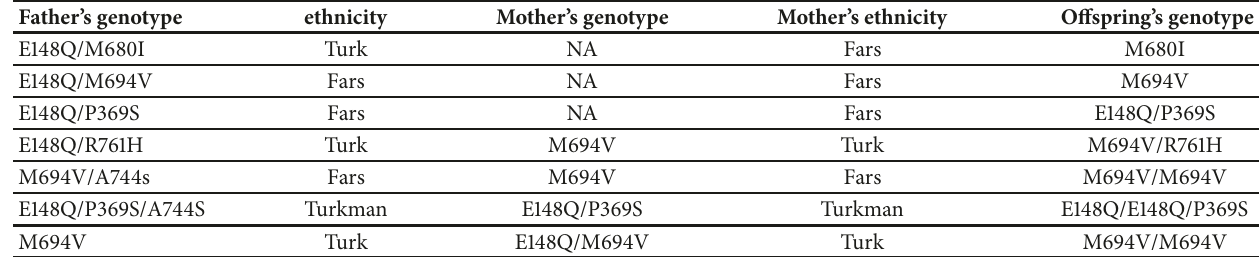
Table 3: Genotype of compound heterozygote mutations in the